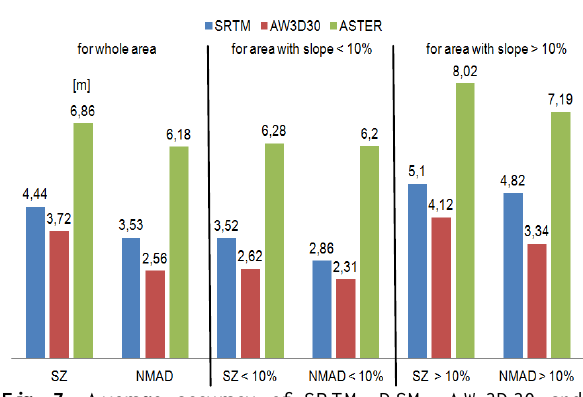
Fig. 7: Average accuracy of SRTM DSM, AW3D30 and ASTER GDEM2 in 5 test areas, using the whole areas, for areas with slope up to 10% and for slope exceeding 10%